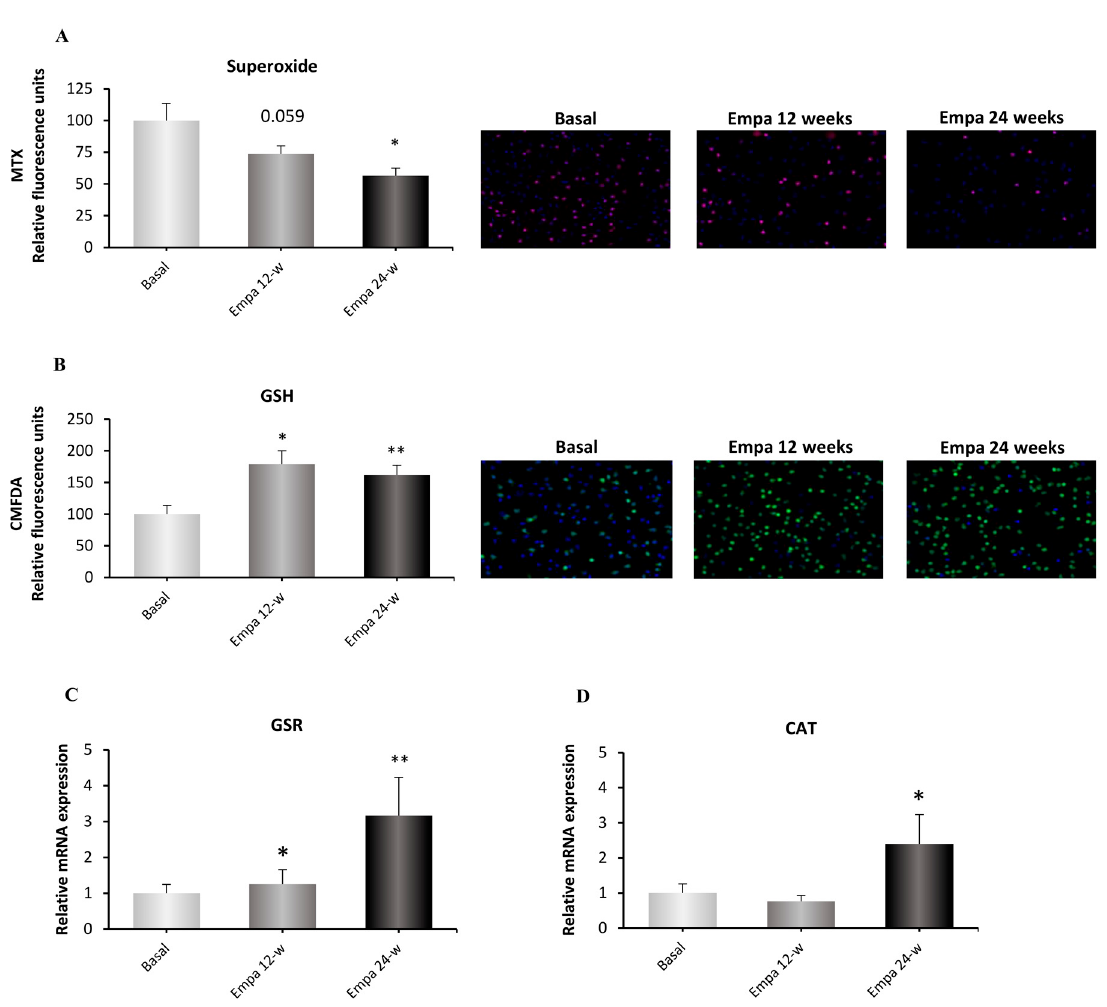
Figure 2. Effect of empagliflozin treatment on oxidative stress parameters and antioxidant enzymes. Mitochondrial superoxide production ( A ), GSH content ( B ) and mRNA expression of the antioxidant enzymes GSR ( C ) and CAT ( D ) in human leukocytes at 12 and 24 weeks of empagliflozin treatment. Data were normalized to fluorescence at baseline. The values of the relative gene expression were normalized to baseline mRNA expression levels and calculated using the 2 −ΔΔ CT method. Abbreviations: EMPA, empagliflozin; MTX, MitoSOX Red mitochondrial superoxide indicator; CMFDA, 5-chloromethylfluorescein diacetate; GSH, glutathione, GSR, glutathione S-reductase; CAT, catalase. * p < 0.05, ** p < 0.05 vs. type 2 diabetes baseline. Representative fluorescence microscopy images are